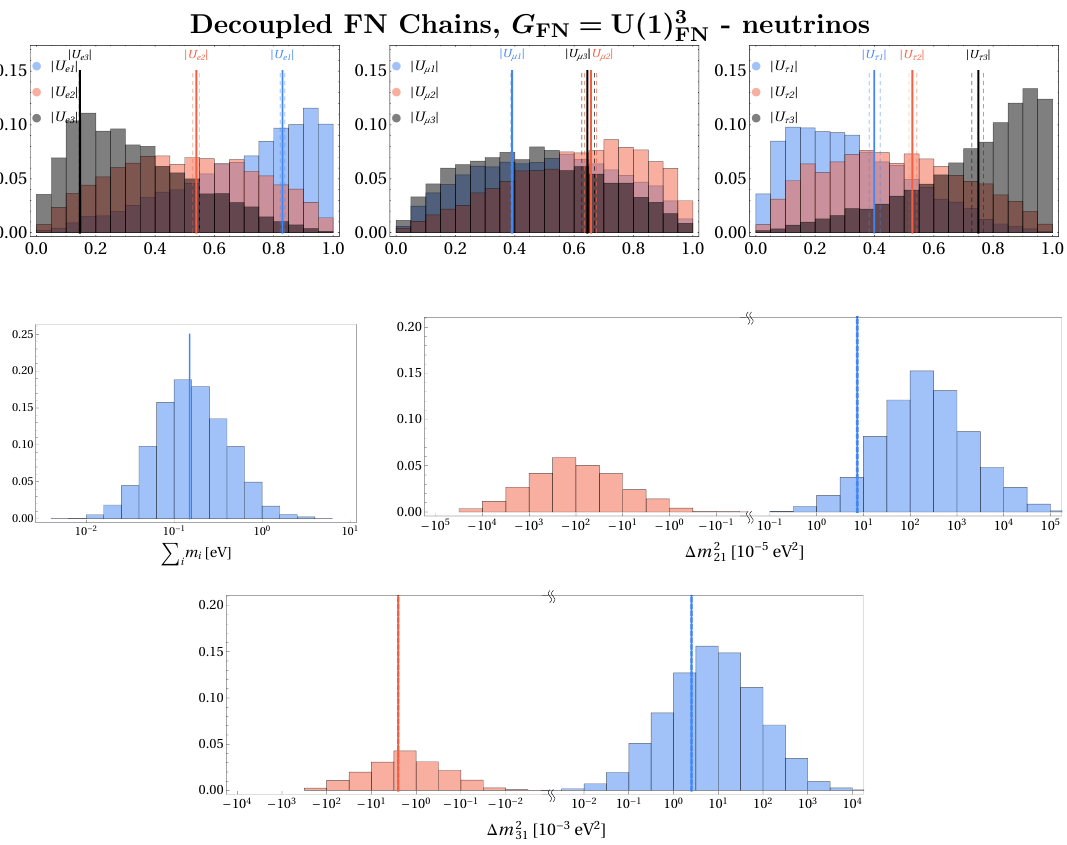
Figure 11 . The distributions of the absolute values of the PMNS matrix elements (top), as well as the sum of neutrino masses P m (cid:23) (middle left) and neutrino mass squared di(cid:11)erences (cid:1) m 2 i i (cid:1) m 2 (middler right and bottom) for the case of decoupled FN chains, G FN = U(1) 3 31 (cid:3) LN = 10 11 GeV. The measured values are shown as vertical bars [1, 32, 33], with dashed lines denoting 1 (cid:27) errors. For P m (cid:23) the upper bound is shown [32], while for (cid:1) m 2 i i blue (orange) for normal (inverted)